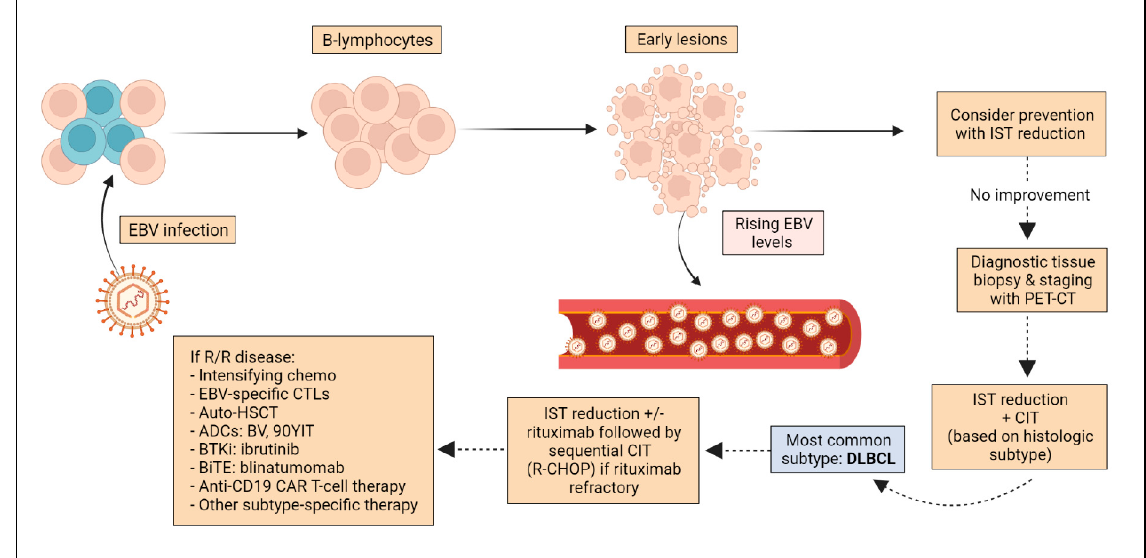
Figure 1. Pathogenesis and treatment algorithm of PLTD. Abbreviations: IST, immunosuppressive therapy; CIT, chemoimmunotherapy; DLBCL, diffuse large B-cell lymphoma; R/R, re- lapsed/refractory, CTLs, cytotoxic T-lymphocytes; HSCT, hematopoietic stem cell transplant; ADCs, Antibody Drug Conjugates; BV, Brentuximab Vedotin; 90YIT, 90 Yttrium ibritumomab tiuxetan; BTKi, Bruton Tyrosine Kinase Inhibitors; BiTE, Bispecific T cell Engagers; CAR, Chimeric Antigen Receptor.